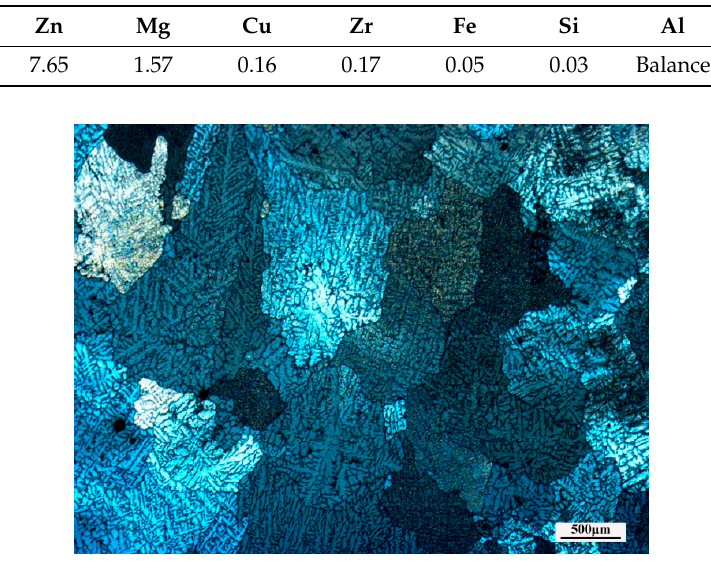
Figure 9. Optical microstructure of the as-homogenized Al–7.5Zn–1.5Mg–0.2Cu–0.2Zr alloy.